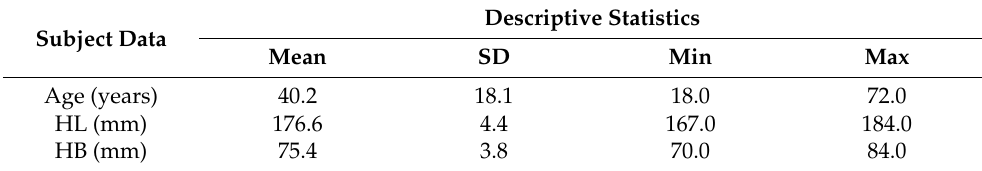
Table 2. Descriptive data of the